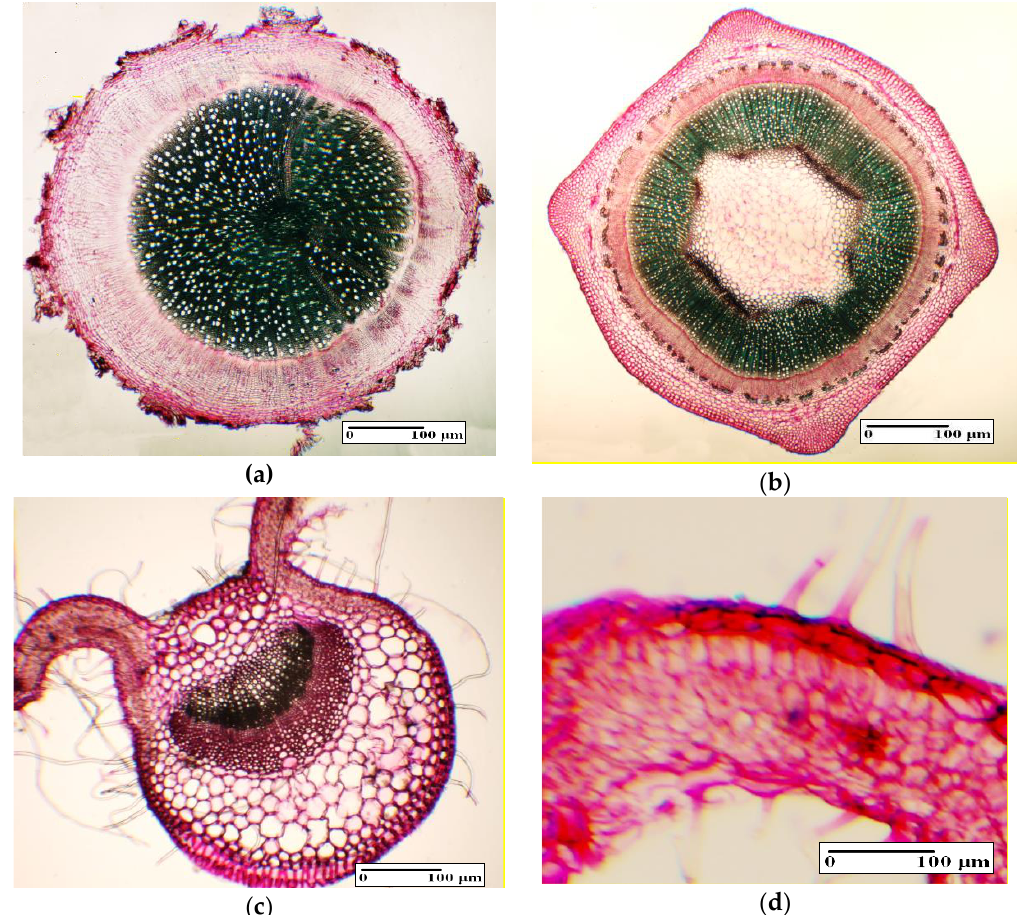
Figure 3. The general aspects of internal structure of sage ( Salvia officinalis L.) vegetative organs: Root ( a ), stem ( b ), main string of leaf ( c ), and leaf lamina ( d ). Table 3. The microscopic characteristics of vegetative organs in case of treated and control sage plants.